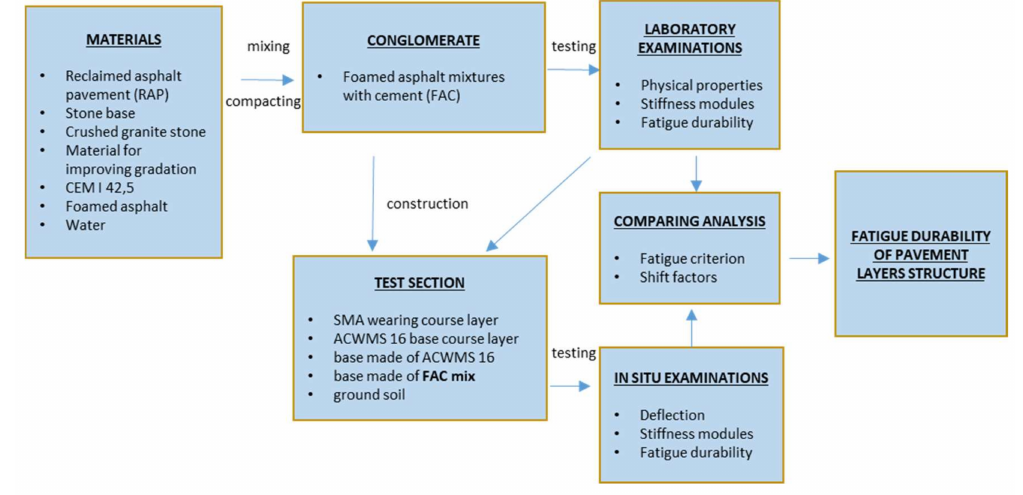
Figure 1. Research methodology flow